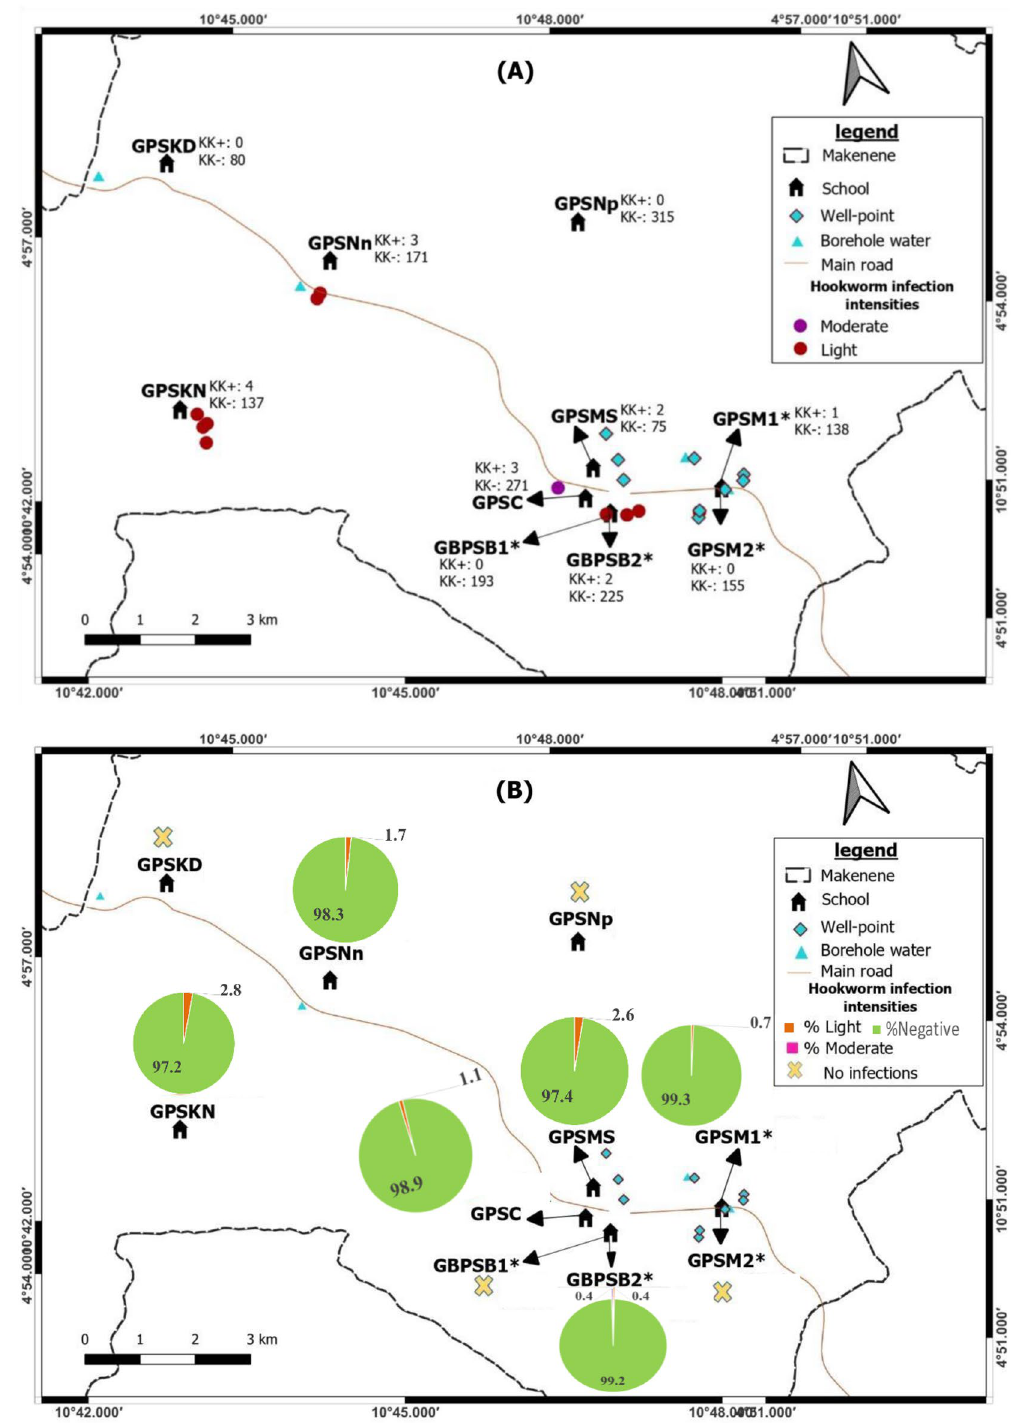
Figure 5. Map showing spatial distribution of hookworm infections ( A ) and its infection intensities ( B ) according to schools (*both schools are hosted on the same building). GBPSB1: Government Bilingual Primary School of Baloua Group 1; GBPSB2: Government Bilingual Primary School of Baloua Group 2; GPSM1: Government Primary School of Makenene Group 1; GPSM2: Government Primary School of Makenene Group 2; GPSNn: Government Primary School of Nyokon; GPSKD: Government Primary School of Kinding Nde; GPSKN: Government Primary School of Kinding-Ndjabi; GPSMS: Government Primary School of Mock-Sud; GPSC: Government Primary School of Carrière; GPSNp: Government Primary School of